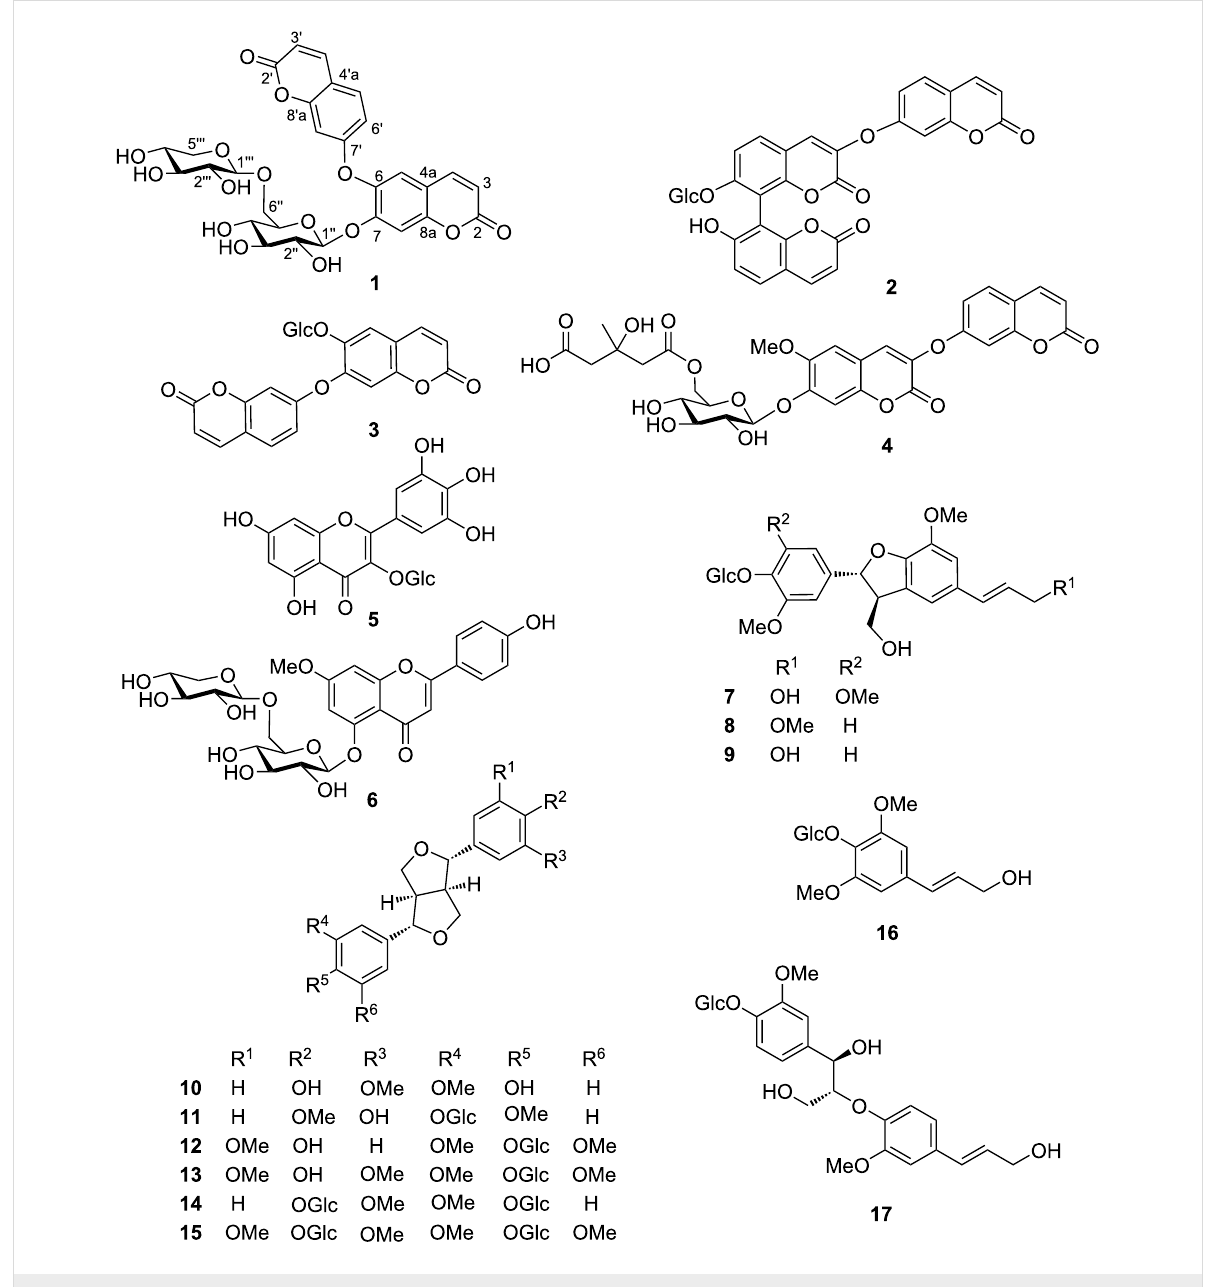
Figure 1: Chemical structures of compounds 1 – 17 from W. nutans